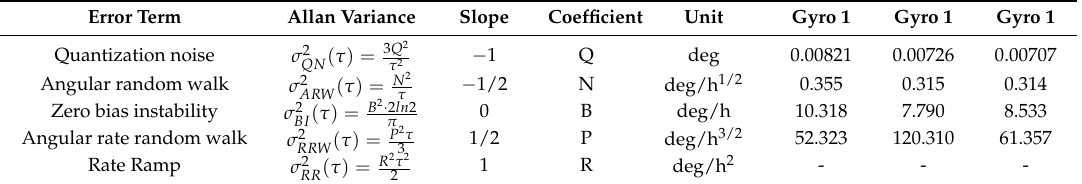
Table 1. The Allan variance of five main random errors in MEMS